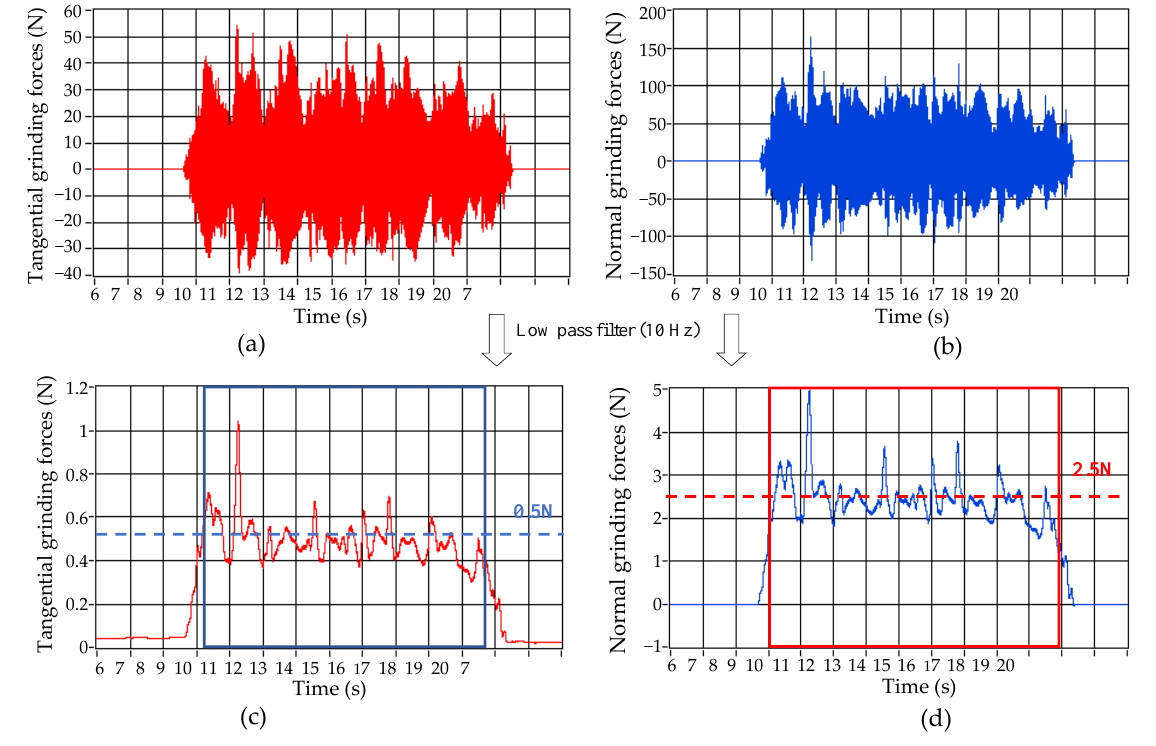
Figure 7. Grinding force (No irradiation, v s = 3000 RPM, v w = 0.1 m/min, a p =15 µ m). ( a ) Original signal of Tangential force. ( b ) Original signal of normal force. ( c ) Filtered signal tangential force. ( d ) Filtered signal of normal force.